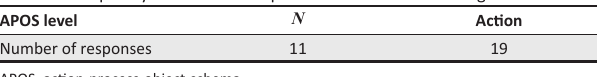
TABLE 3: Frequency of students’ responses for task 1a according to APOS